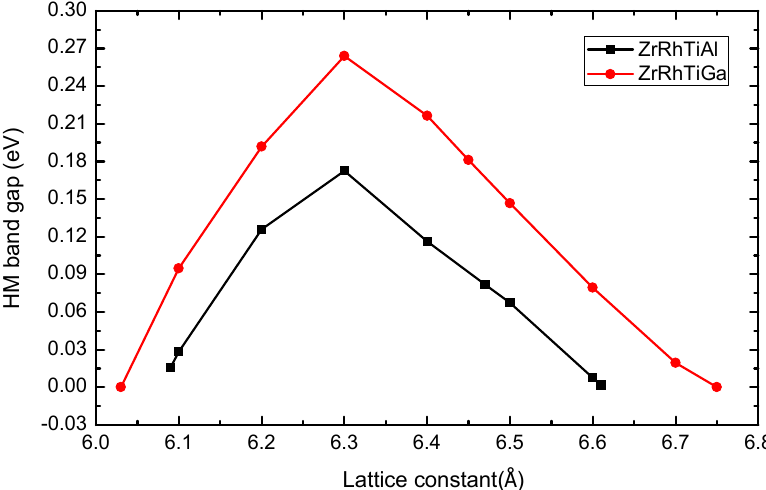
Figure 9. The half-metallic band-gap as a function of the lattice constant (US) for ZrRhTiAl and ZrRhTiGa.